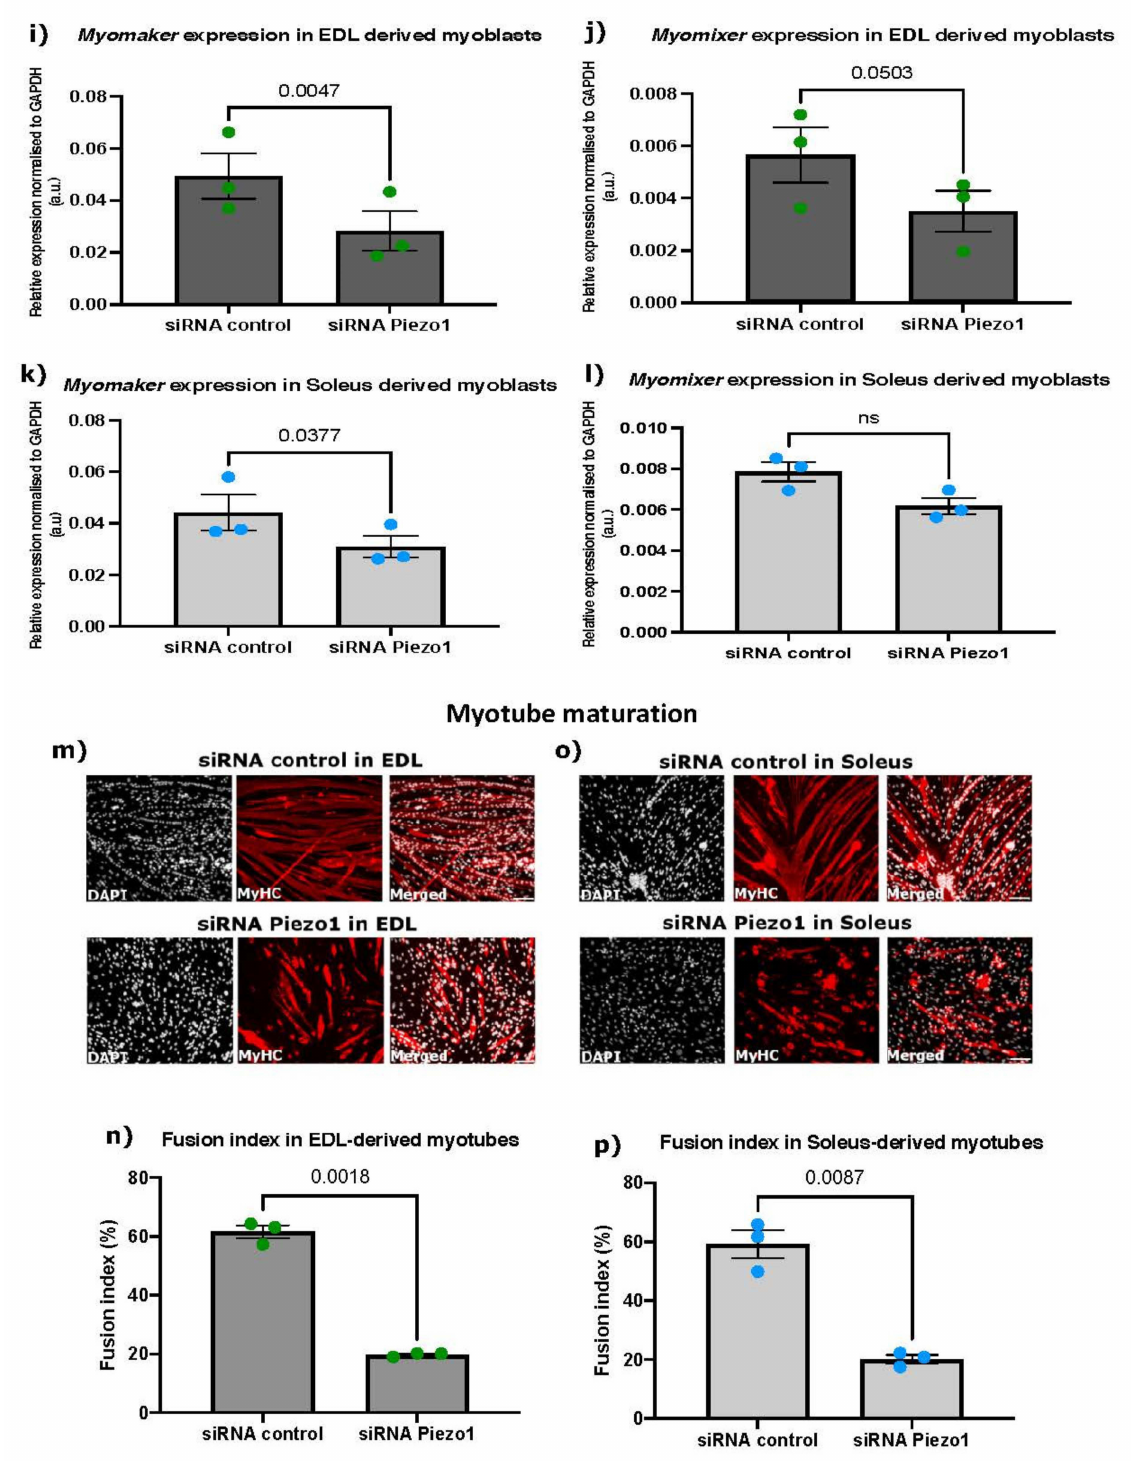
Figure 3. Piezo1 knockdown reduces expression of fusogens and myoblast fusion. ( a , c ) Represen- tative images of EDL- and SOL-derived myoblasts transfected with 10 nM of control-siRNA (siRNA control) or Piezo1 -siRNA. Following overnight incubation, cells were incubated for a further 24 h in differentiation medium, immunolabelled for Myogenin (red panels), and counterstained with DAPI (black and white panels). Scale bar is 100 µ m. ( b , d ) Percentage proportion of Myogenin-positive cells relative to total nuclei. ( n = 4 mice). ( e , g ) Representative images of myotubes from EDL and SOL, transfected with 10 nM of control-siRNA or Piezo1 -siRNA. Following overnight incubation, cells